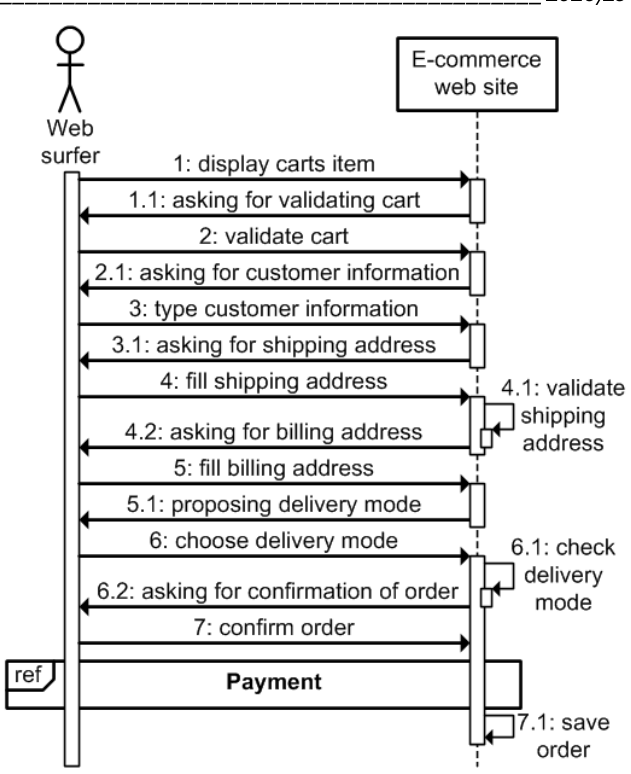
Fig. 8. Sequence diagram of system’s external behaviour for the checkout sub- process, obtained by applying